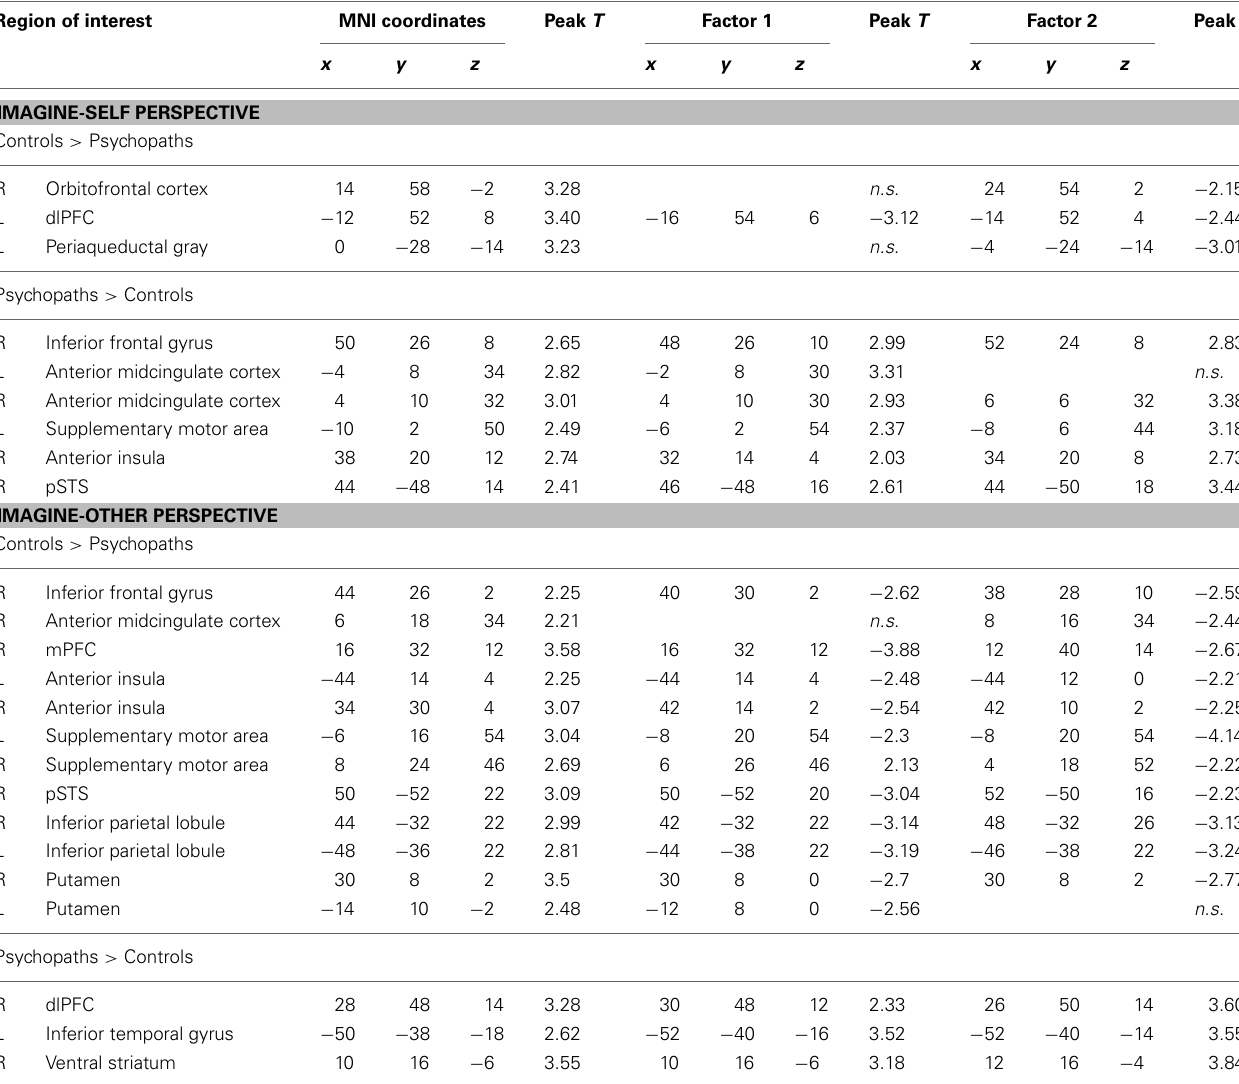
Table 3 | Groupwise results and factor sub-score covariates for imagine-self and imagine-other perspectives. Region of